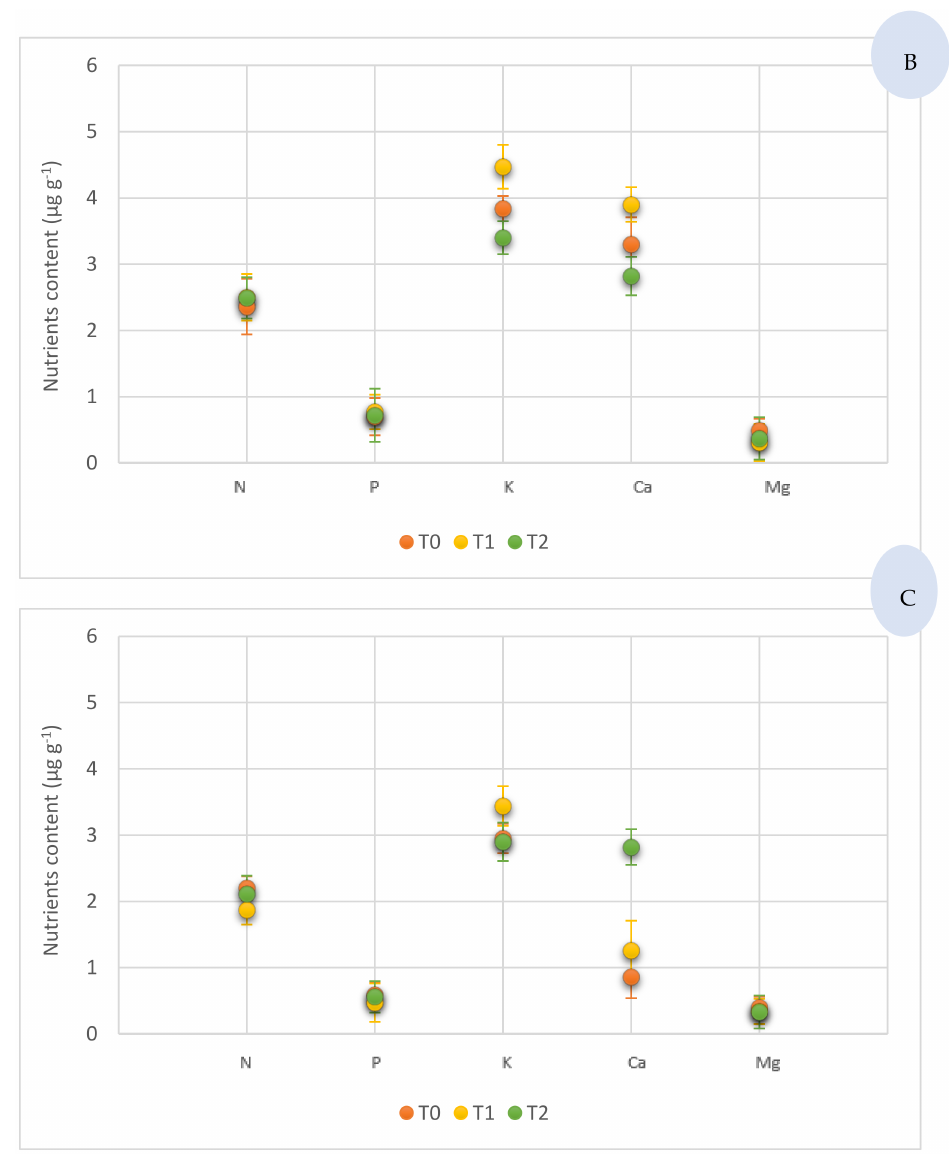
Figure 2. Macronutrient content in di ff erent tomato components under sodium selenite treatments. ( A ) Leaves, ( B ) Stems, ( C ) Fruits. T0 = 0 mg L − 1 , T1 = 2 mg L − 1 , T2 = 5 mg L − 1